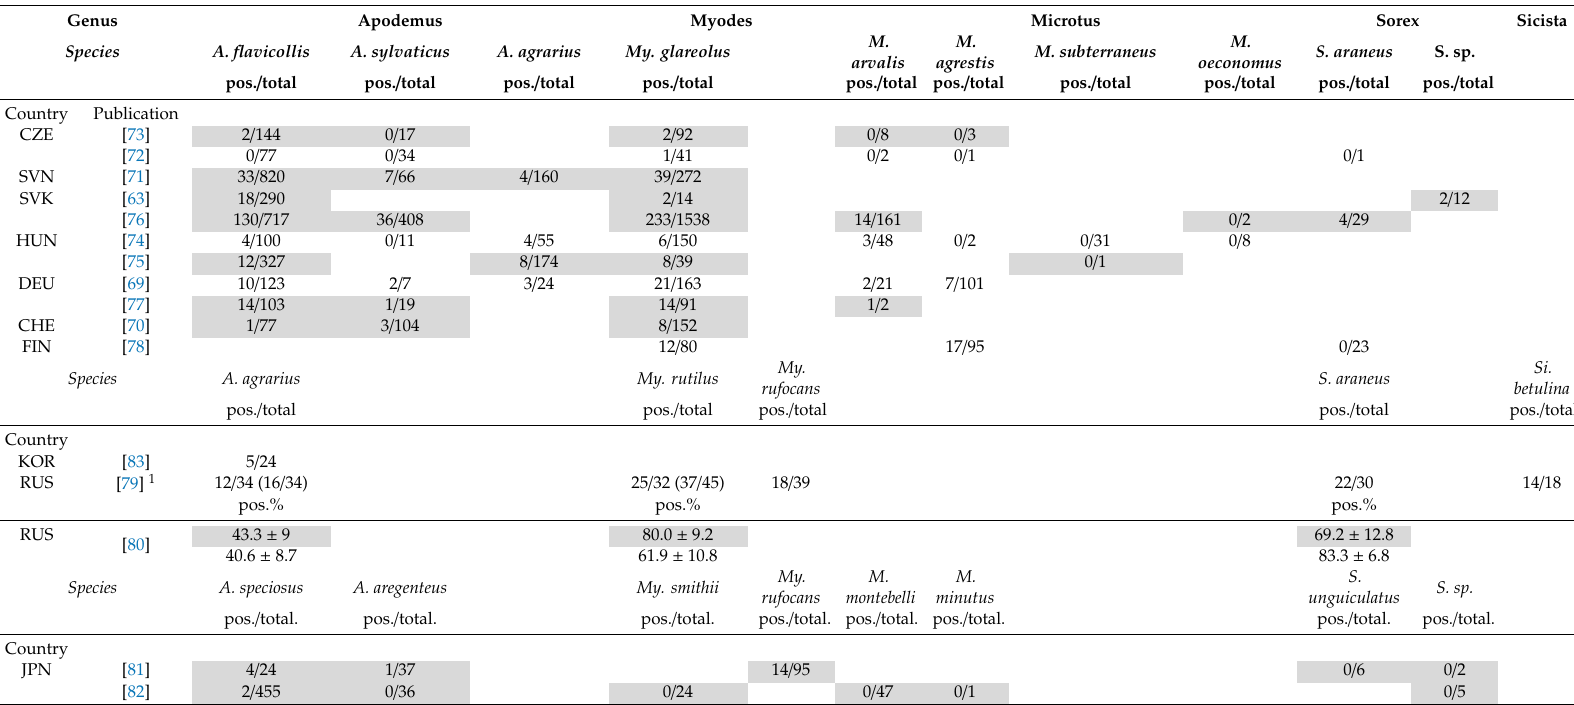
Table 1. Small mammalian animals caught in TBEV studies worldwide. Studies focusing on antibody prevalence are shaded in grey; the remaining studies were conducted by screening for viral RNA. CHE—Switzerland; CZE—Czech Republic; DEU—Germany; FIN—Finland; HUN—Hungary; JPN—Japan; KOR—South Korea; RUS—Russia; SVK—Slovakia; SVN—Slovenia.